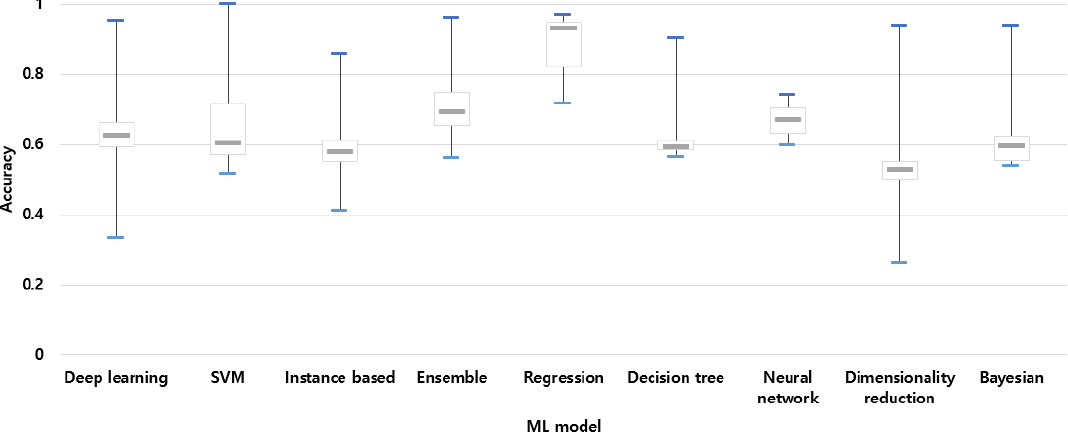
Figure 14. Box plots for R.